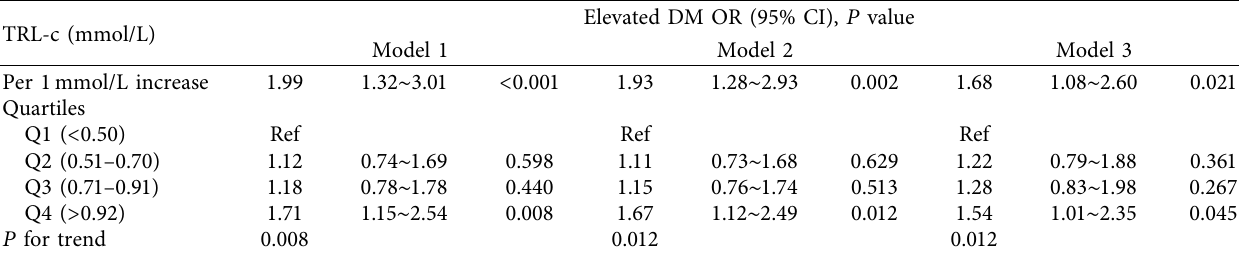
Table 3: Association between TRL-c and DM in diferent models ( n � 890).